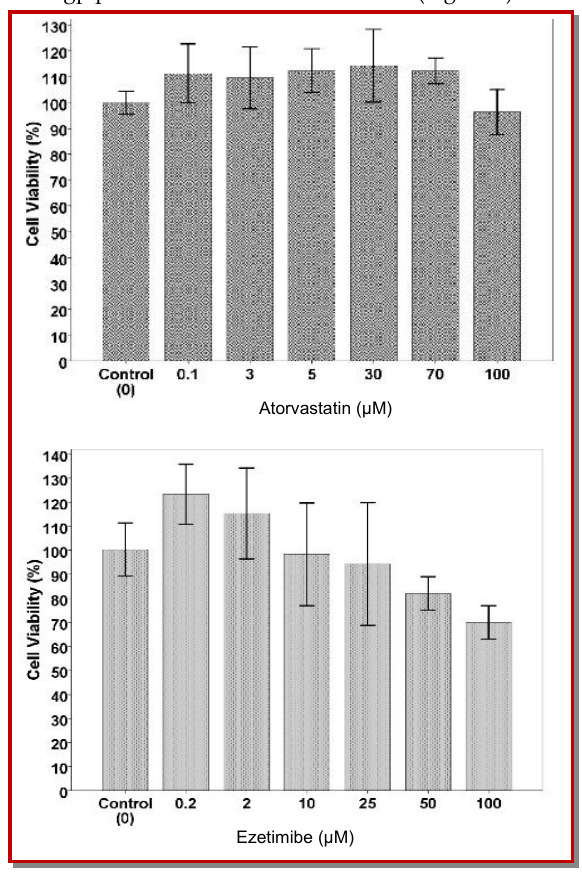
Figure 2: Effects of different concentrations of atorvastatin (upper figure) and ezetimibe (lower figure) on Caco-2 cell viability measured by MTT assay. Data are mean ± SD of three separate experiments. The treatments were not significantly different from the untreated control at